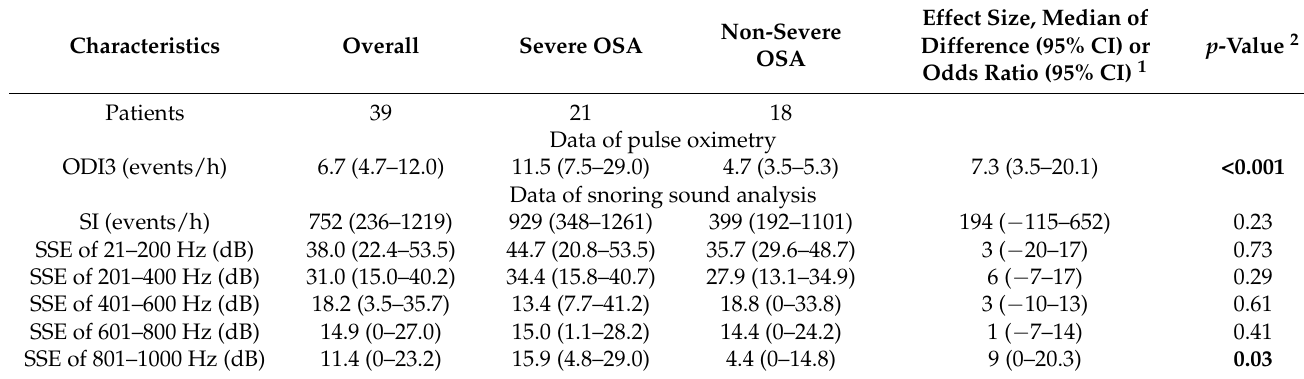
Table 2. Home sleep apnea test variables of Study